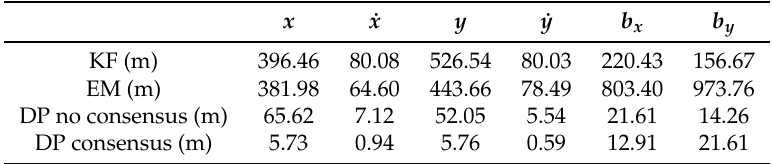
Table 7. Comparison of peak estimation error values of the network of 60 sensors.